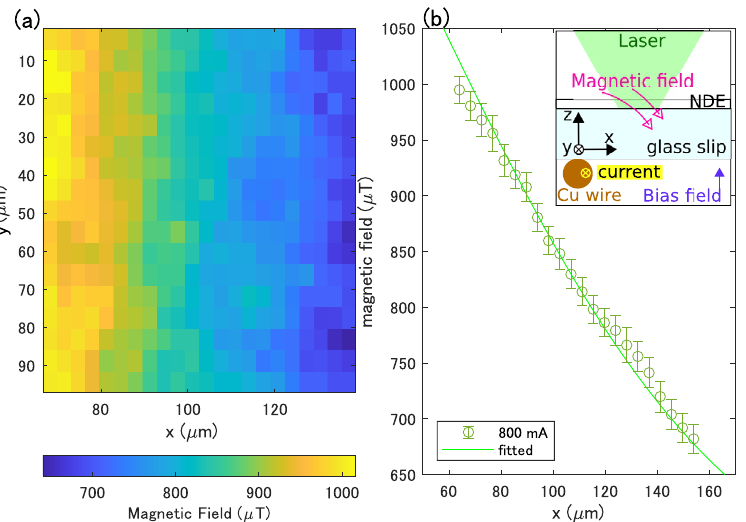
Figure 3. Magnetic field imaging enhanced by machine learning. ( a ) Magnetic field distribution when a current of 800 mA is applied to the copper wire, which is placed along the y-direction. The horizontal axis is the distance 0 µ m. ( b ) The average magnetic field value against the to the x-direction when the copper wire is placed at x = y-axis direction in ( a ). The solid curve is the result of the fitting based on Ampere’s law. (Inset) Measurement configuration, where the bias field applied in the z-direction and the field generated by the current through the wire are simultaneously felt by the NDE.